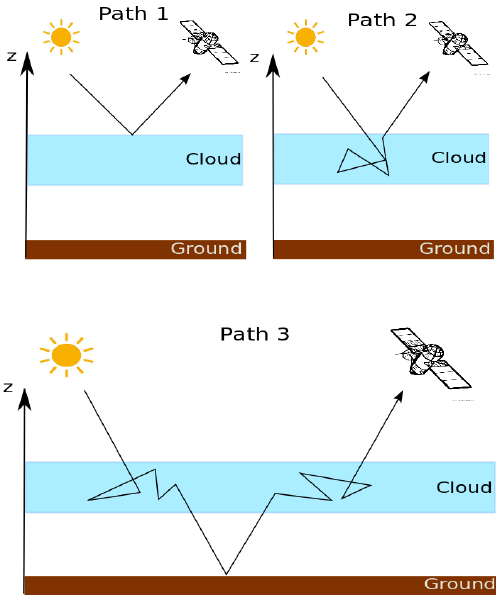
Figure 3. Basic pathways for a reflected photon through the atmosphere–surface system to reach the sensors. Molecular reflec- tion which is weak is not